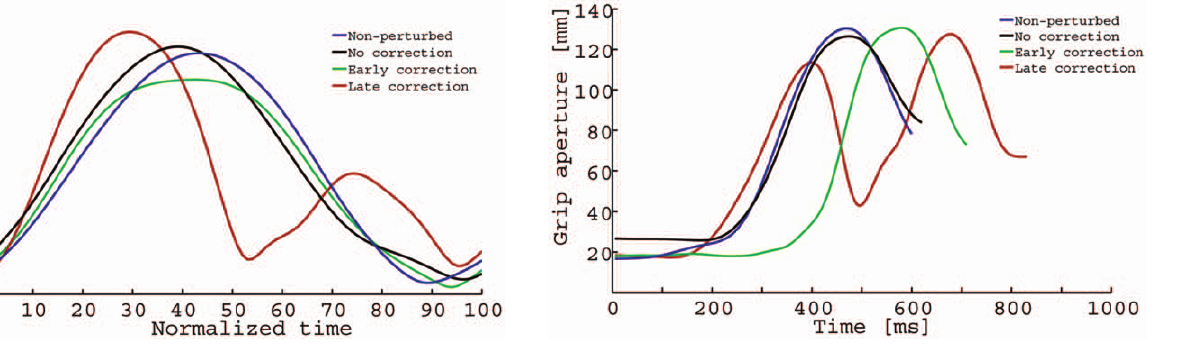
Figure 5. Representative relative velocity profiles during the reach-to-grasp phase.